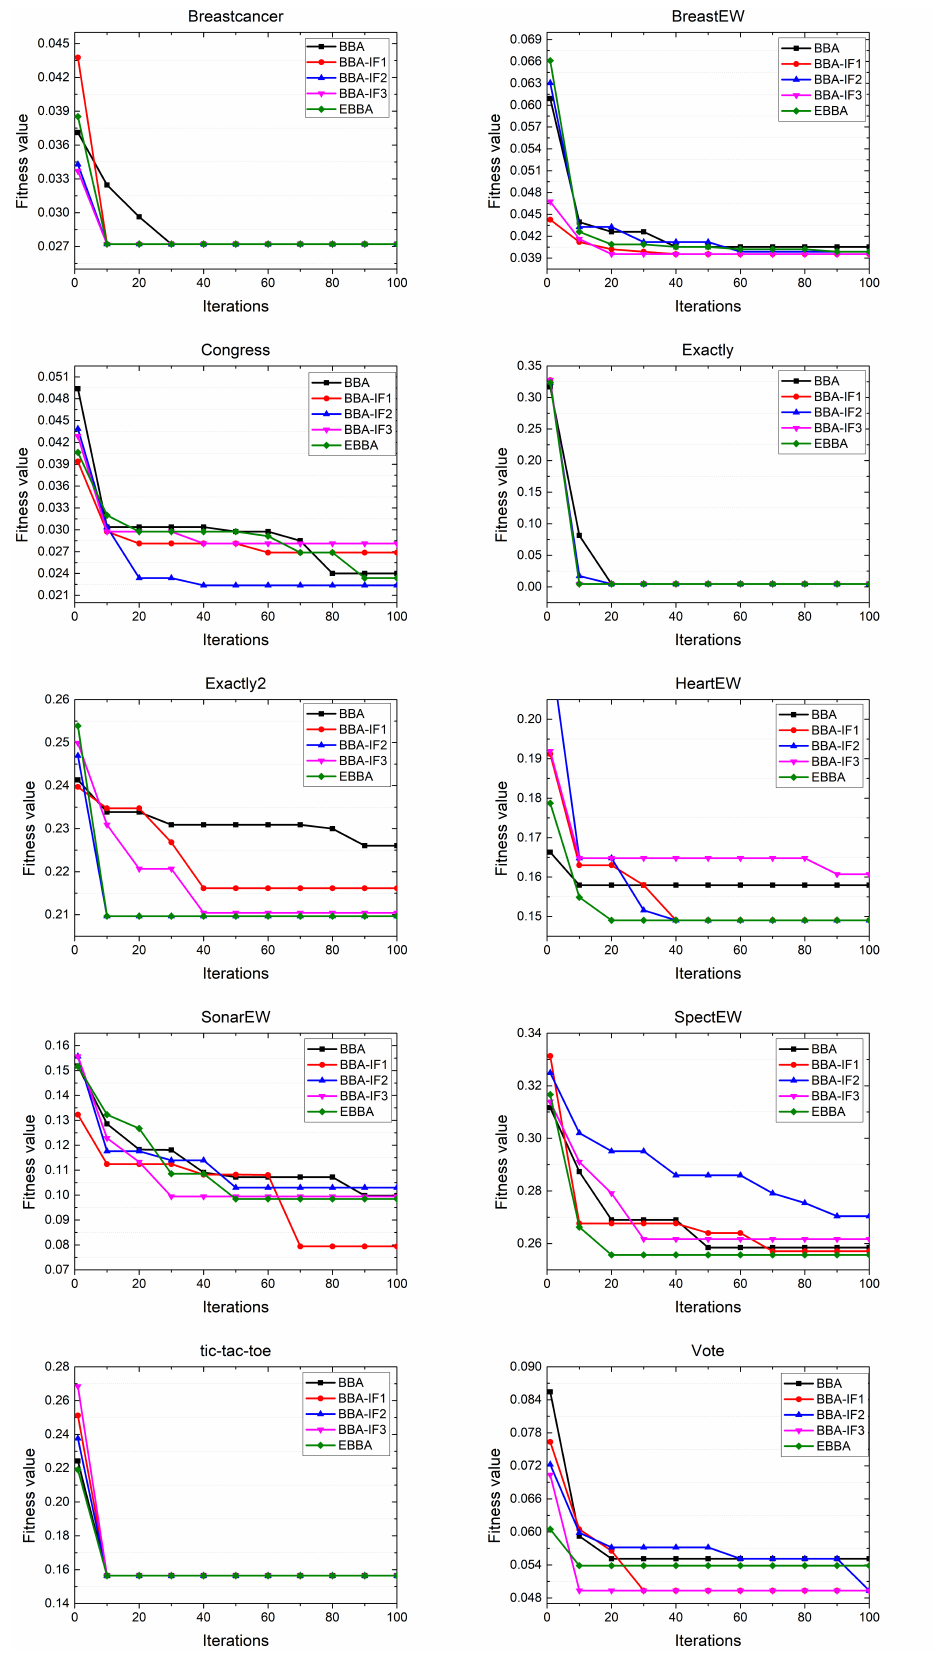
Figure 3. Convergence rates obtained by different EBBA